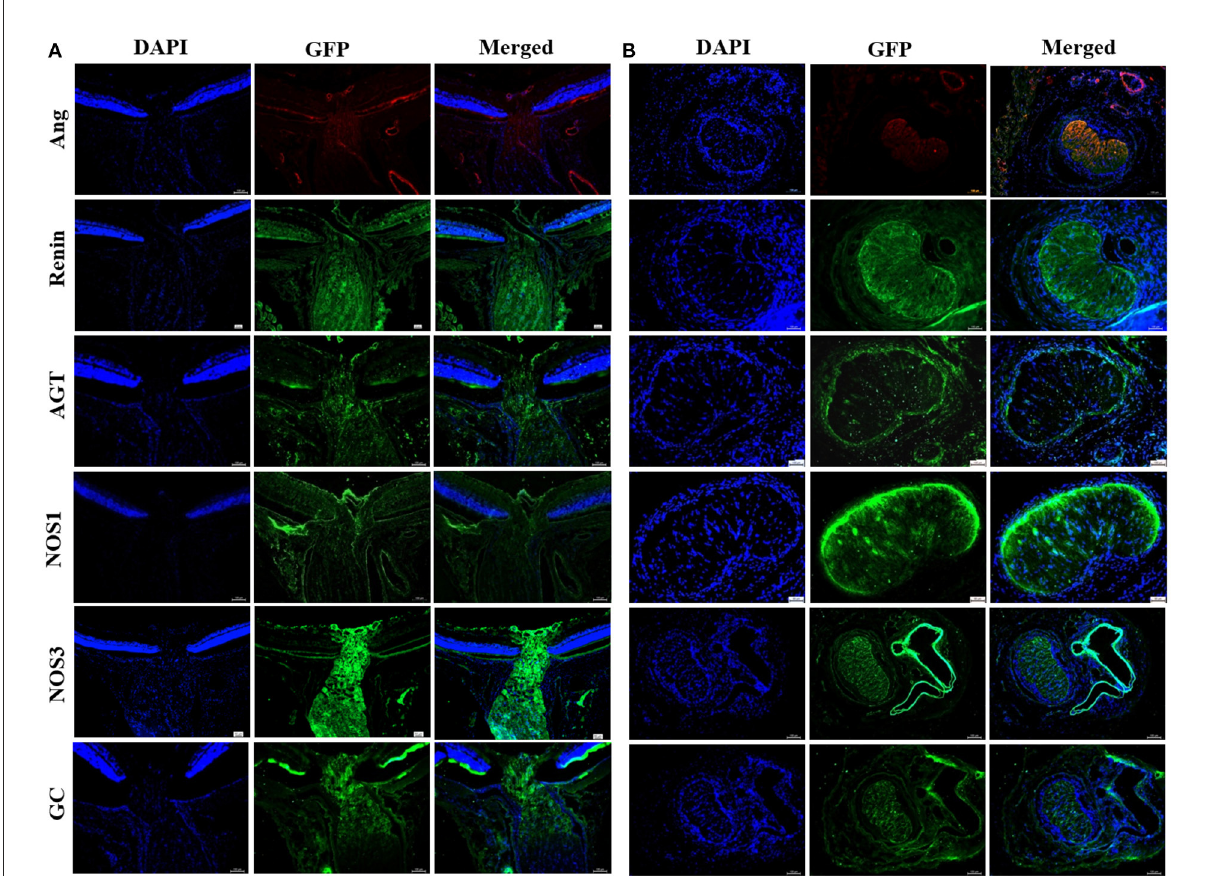
FIGURE3 Immunofluorescent staining of NOS and RAS components in rat LC tissues. (A) Longitudinal section of LC tissue showed positive staining of Ang, renin, AGT, NOS1, NOS3, and GC. (B) Horizontal section of LC tissue showed positive staining of Ang, renin, AGT, NOS1, NOS3, and GC. LC, Lamina cribrosa; Ang, Angiotensin; AGT, Angiotensinogen; NOS, Nitric oxide synthase; GC, Guanylate